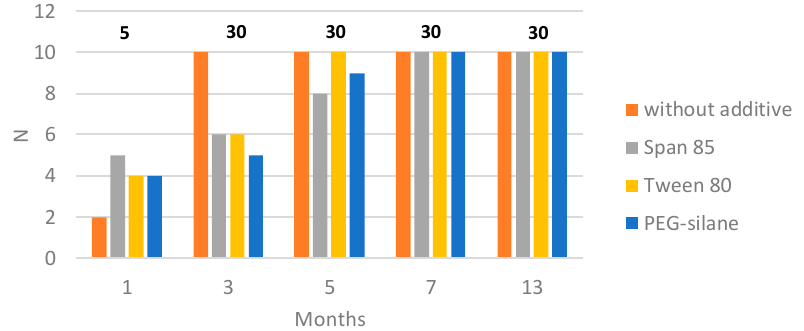
Figure 8. Values of the antifouling efficiency N for paints immersed for 1, 3, 5, 7 and 13 months in Atlantic Ocean. Values mentioned on the top of the figure correspond to the N values quantified for an unprotected surface.